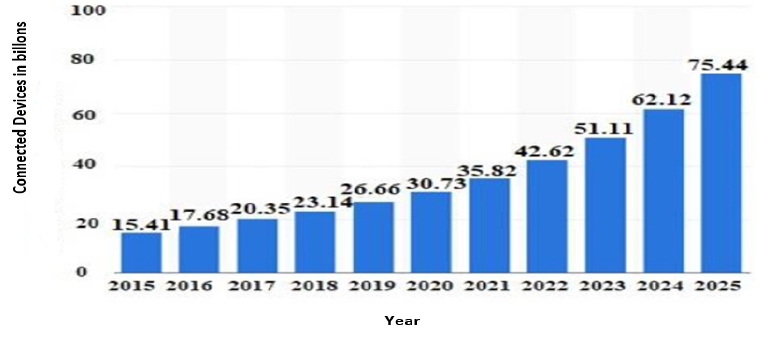
Figure 1. Number of Internet of Things (IoT) connected devices estimated up until 2025 [7].